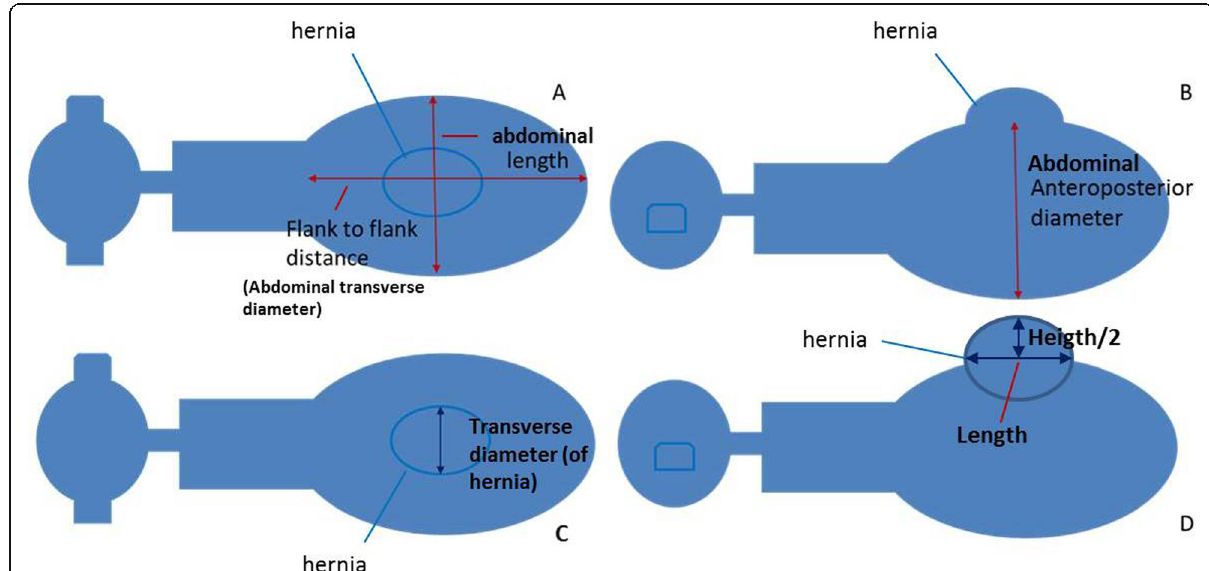
Fig. 2 Abdominal measurements needed to evaluate POVH and response to treatment. a , b Abdominal measurements (xiphoid to pubis distance, abdominal height minus hernia protrusion, transverse abdominal measurement). c , d Measurements of the hernia (transverse diameter, length, and height). a , c Patient supine, frontal view; b , d patient supine, lateral